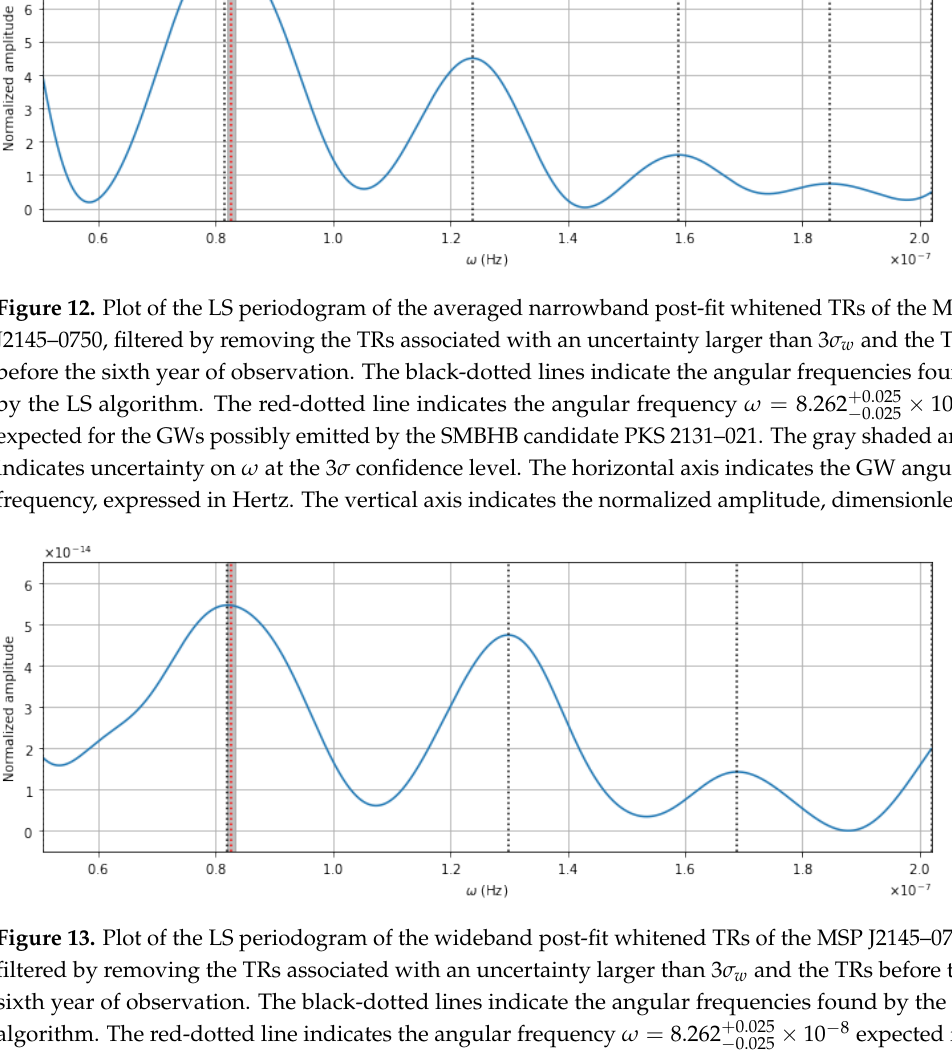
Figure 13. Plot of the LS periodogram of the wideband post-fit whitened TRs of the MSP J2145–0750, filtered by removing the TRs associated with an uncertainty larger than 3 σ w and the TRs before the sixth year of observation. The black-dotted lines indicate the angular frequencies found by the LS × 10 − 8 expected for algorithm. The red-dotted line indicates the angular frequency ω = 8.262 + 0.025 − 0.025 the GWs possibly emitted by the SMBHB candidate PKS 2131–021. The gray shaded area indicates uncertainty on ω at the 3 σ confidence level. The horizontal axis indicates the GW angular frequency, expressed in Hertz. The vertical axis indicates the normalized amplitude,